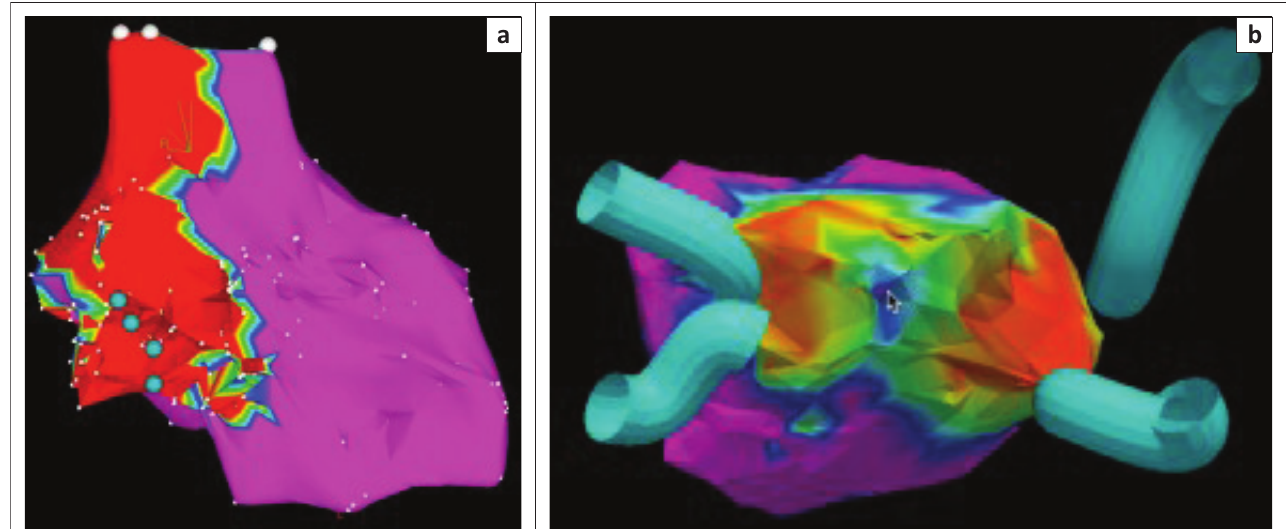
FIGURE 3: Electroanatomical maps (EAMs) of cardiac chambers: (a) EAM of the left ventricle. Red areas represent low voltage (scar) and purple areas represent normal voltage; (b) EAM of the left atrium, with tubular structures representing the pulmonary veins. Area of ablation shows low voltage (red) and non-ablated areas show normal voltage (purple).